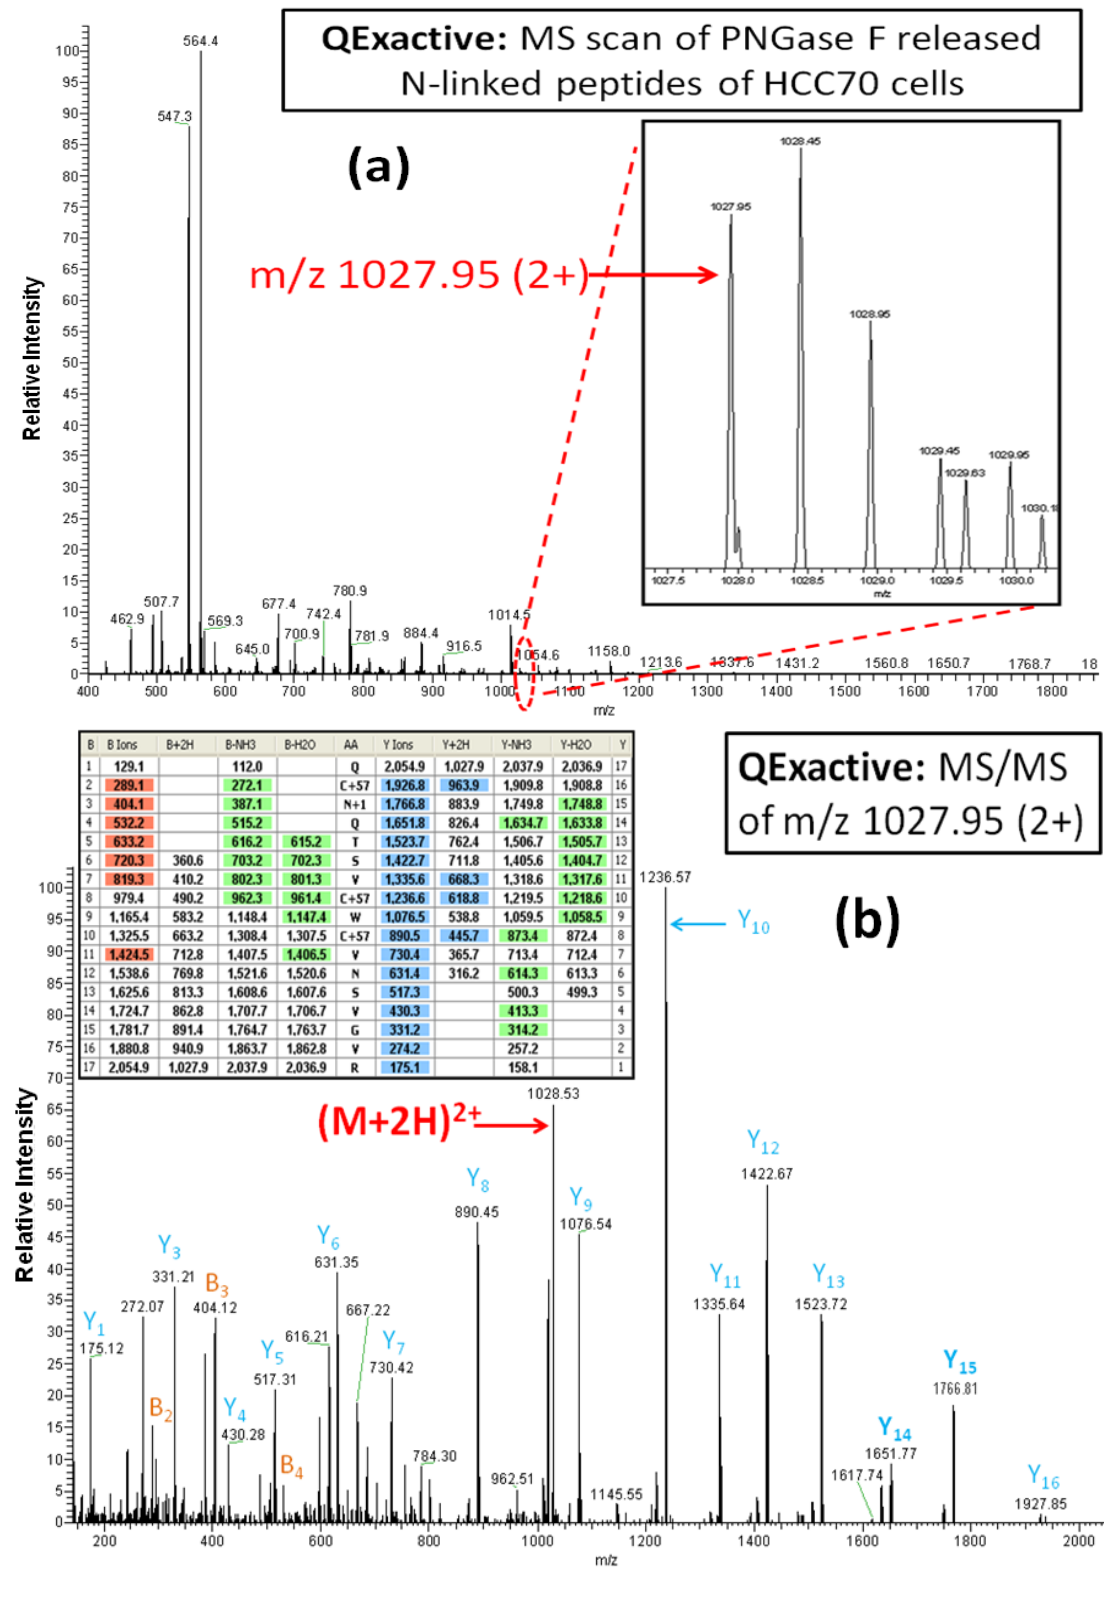
Figure 4. The Q Exactive MS spectrum ( a ) and the HCD-MS/MS spectrum ( b ) of the glycopeptide QCN*QTSVCWCVNSVGVR (AA#118-134, N* denotes a conversion of N to D for the N -linked site Asn 120 ) from tumor-associated calcium signal transducer 2. The mass difference of 115 Da between y14 and y15 confirms the conversion Asn 12 ° to Asp by PNGase